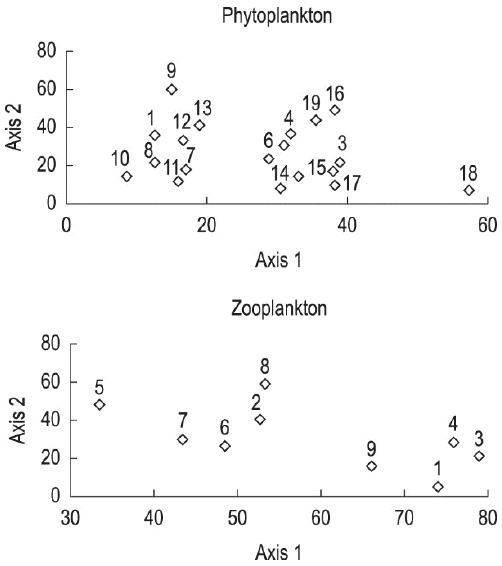
Figure 7. Ordination of the Nile plankton clusters along the first two axes of